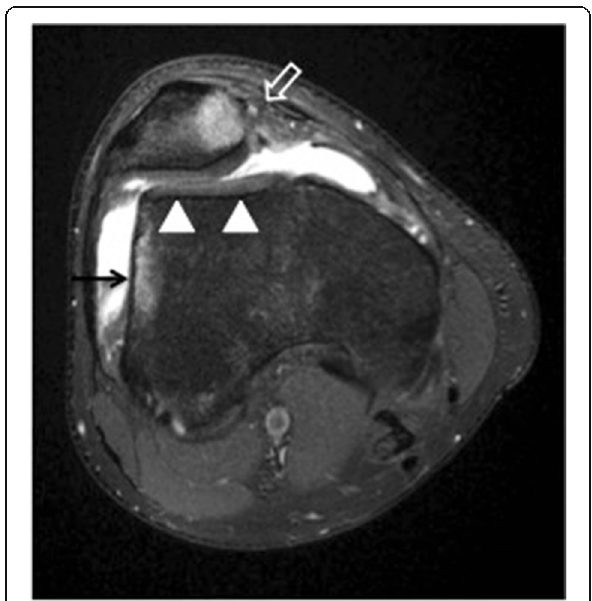
Fig. 7 Transient lateral patellar dislocation. Axial PDFS MR image showing MPFL disruption (open arrow) and trochlear dysplasia (arrowheads). There is edema of the medial patella and of the lateral femoral condyle (arrow), consistent with bone contusion due to recent lateral patellar